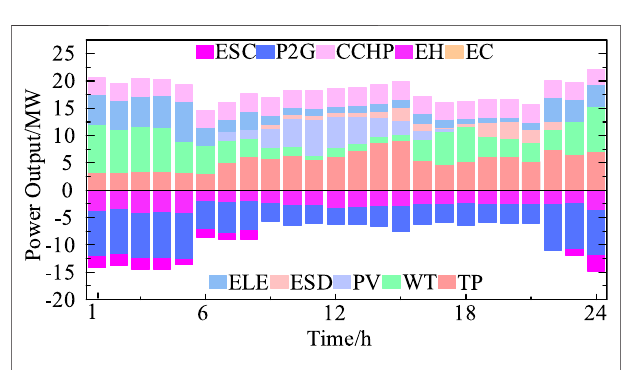
FIGURE 7 | Operation of each unit in case 3.